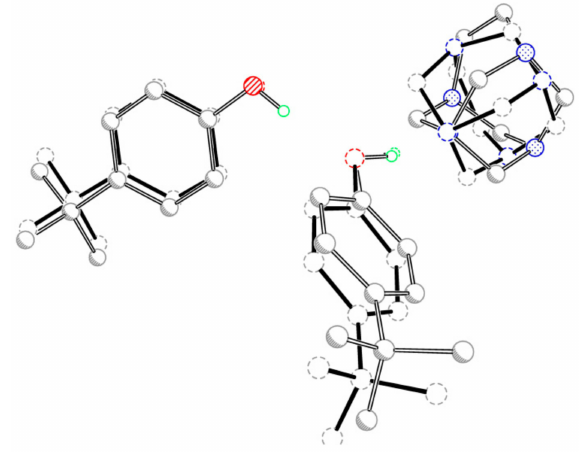
Figure 2. Overlay plot of the two three-molecule aggregates in title compounds (I and II), with the O1, O2 and N1 atoms as the common basis.